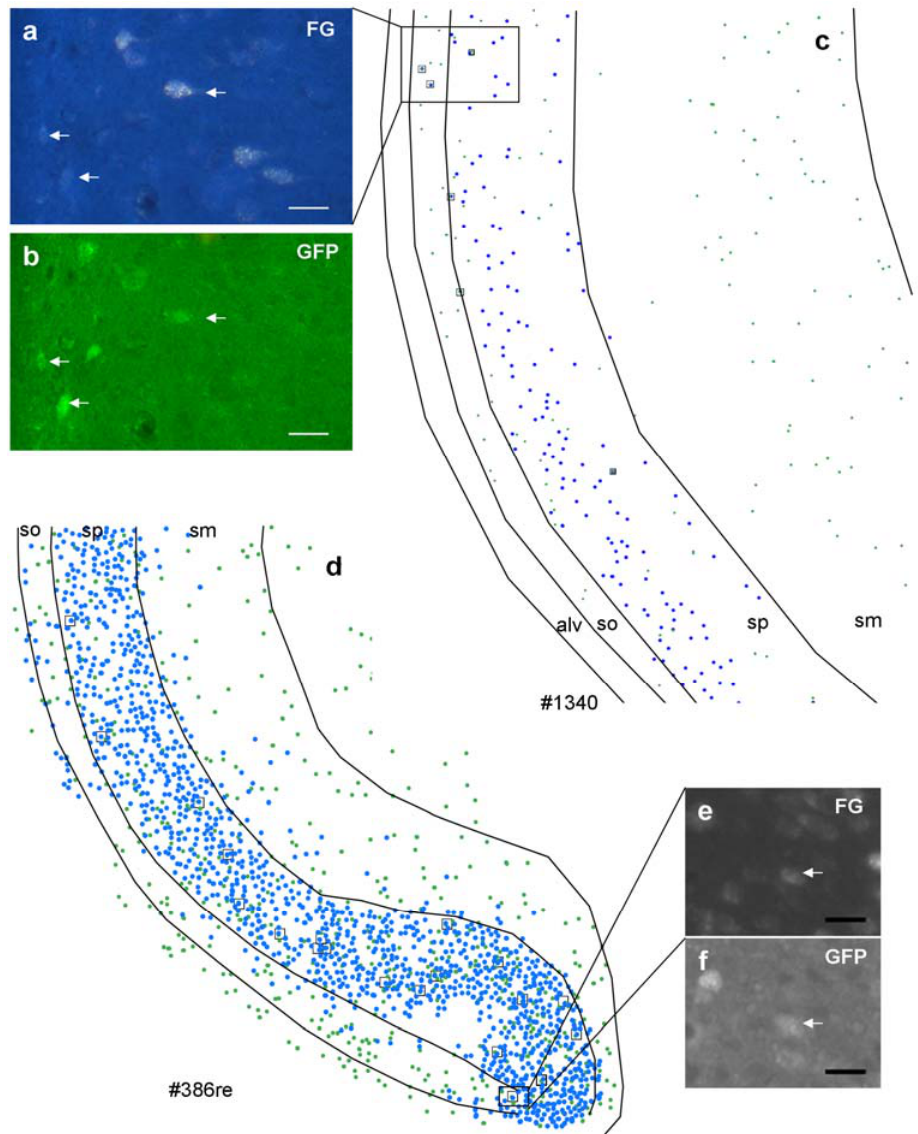
Figure 3. Distribution of retrogradely labeled (blue spots) and GABAergic neurons (green spots) in the ventral hippocampus after an iontophoretic ( c ) and after a pressure injection ( d ). Case numbers of injections are indicated below the chart. Note that the distribution pattern is identical after both injections; however, numbers of retrogradely labeled neurons differ dramatically. In the boxed areas, retrogradely-labeled GABAergic neurons were shown (( a ), FG; ( b ), GFP after iontophoretic injection; ( e ), FG; ( f ), GFP after pressure injection). Note that retrogradely labeled neurons are also variably labeled. Calibration bars = 20 μ m (( a ), ( b ), ( e ), and ( f )). Number of retrogradely-labeled neurons and number of double labeled neurons per section in the ventral hippocampus after iontophoretic injections of FG into different nuclei of the amygdala. BLv, basolateral nucleus of the amygdala ventral part; BLA, basolateral nucleus of the amygdala, anterior part; BM, basomedial nucleus of the amygdala (P, posterior part); CeL, central nucleus of